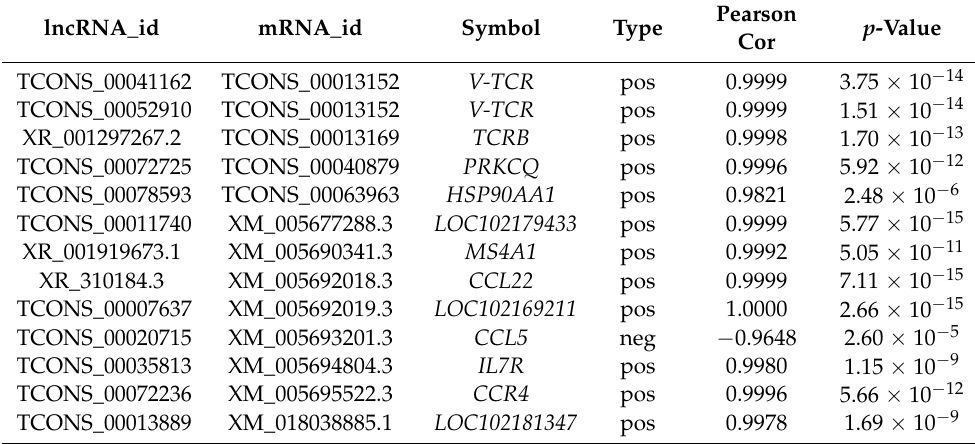
Table 7. Statistics of lncRNA trans-regulated genes in significantly enriched immune-related